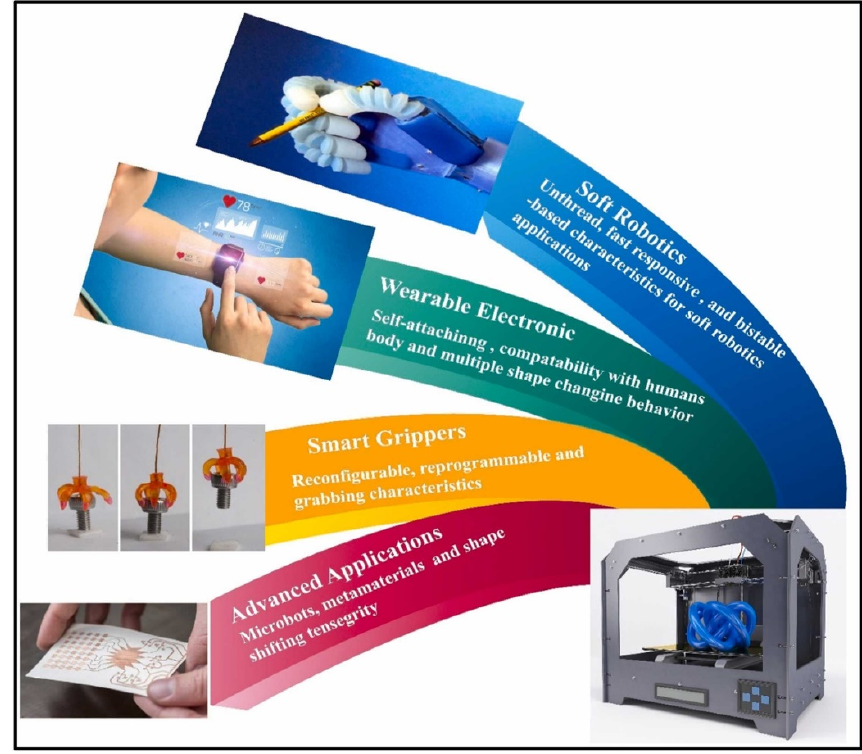
Figure 12. Applications of 4D printed smart materials [87]. Ge et al. [78] introduced the concept of printing an active origami structure using active composites with time-memory polymer fibers printed into an elastomer matrix, automatically folding a flat surface into a complex 3D component (Figure 13). Wan et al. [88] presented the 4D printing process of several biocompatible and biodegradable SMP polymer materials and their nanocomposites that respond to thermal and magnetic stimuli.